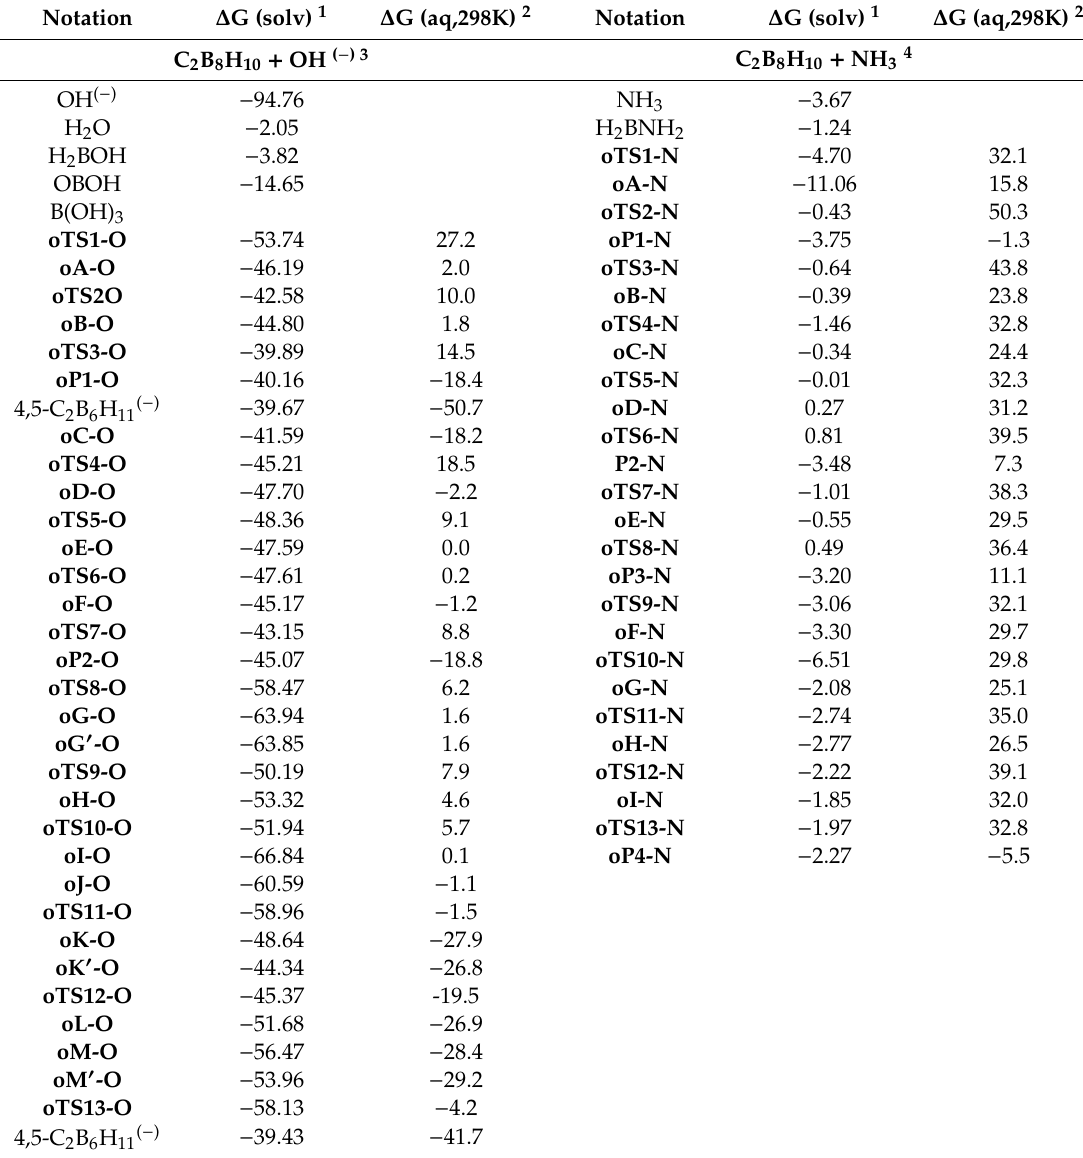
Table 1. Solvation free energies (kcal · mol − 1 ), and free energies relative to the appropriate reference. The small “o” refers to ortho (1,2-) C 2 B 8 H 10 . The capital letters “ A ”, “ B ”, “ C ”, etc. and “TS#” are related to individual intermediates and transition states, respectively. If there were two conformations possible, two letters are used to di ff erentiate between them (e.g., oG / G (cid:48) - O , oK / K (cid:48) - O and oM / M (cid:48) - O ). The capital “- O ” and “- N ” distinguish between the reactions of OH ( − ) and NH 3 , respectively. Wherever the intermediate is relatively stable (and already isolated or possibly trappable), “ P1 ”, “ P2 ”, “ P3 ”, etc. are used instead of “ A ”, “ B ”, “ C